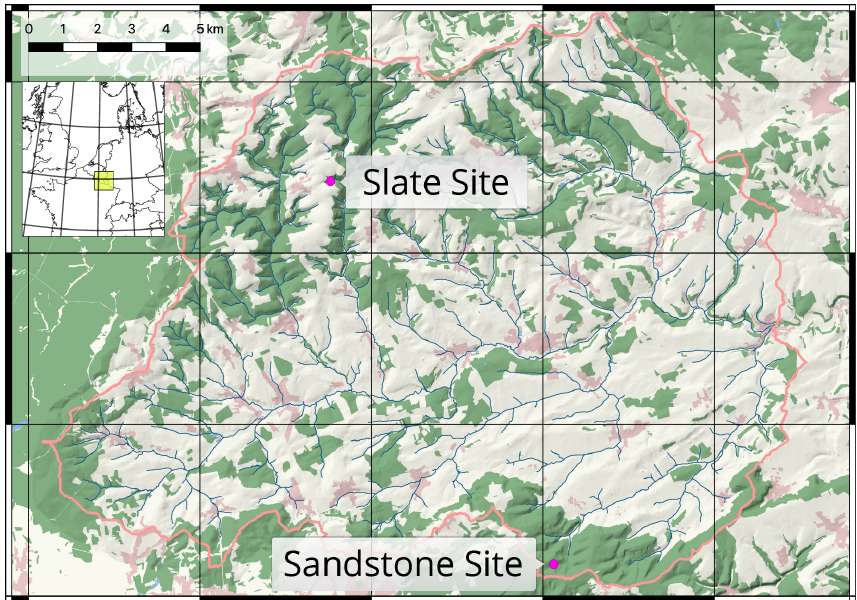
Figure 1. Attert experimental basin in western Luxembourg. Locations of the two reference sites. Basemap: © OpenStreetMap contributors, 2018. (Distributed under a Creative Commons BY–SA license.) Shading and river network calculated with a combined digital elevation model (DEM) of the administrations of Luxembourg and